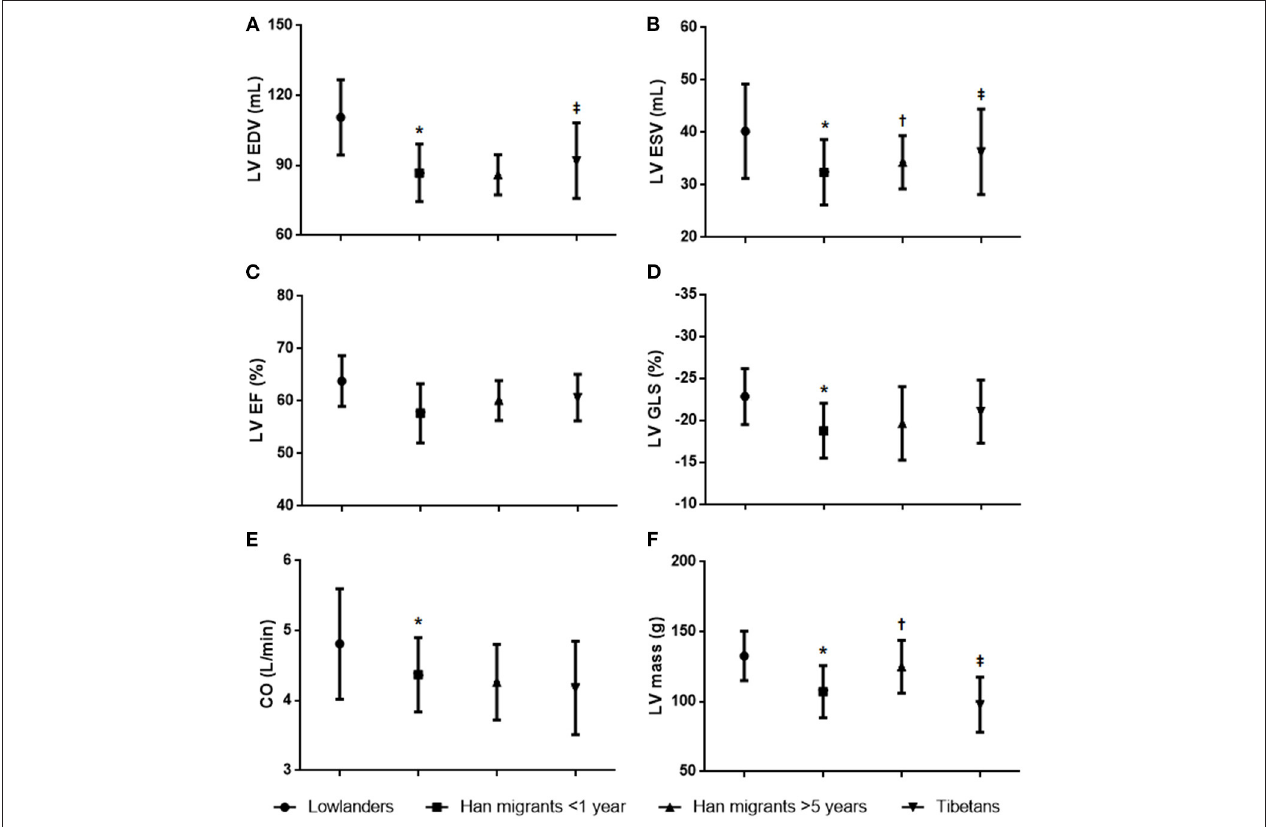
FIGURE 2 | Between-group comparisons of left ventricular characteristics. (A) Left ventricular end-diastolic volume. (B) Left ventricular end-systolic volume. (C) Left ventricular ejection fraction. (D) Left ventricular global longitudinal strain. (E) Cardiac output. (F) Left ventricular mass. * p < 0.05 Han migrants < 1 year vs. lowlanders; † p < 0.05 Han migrants > 5 years vs. Han migrants < 1 year; ‡ p < 0.05 Tibetans vs. Han migrants > 5